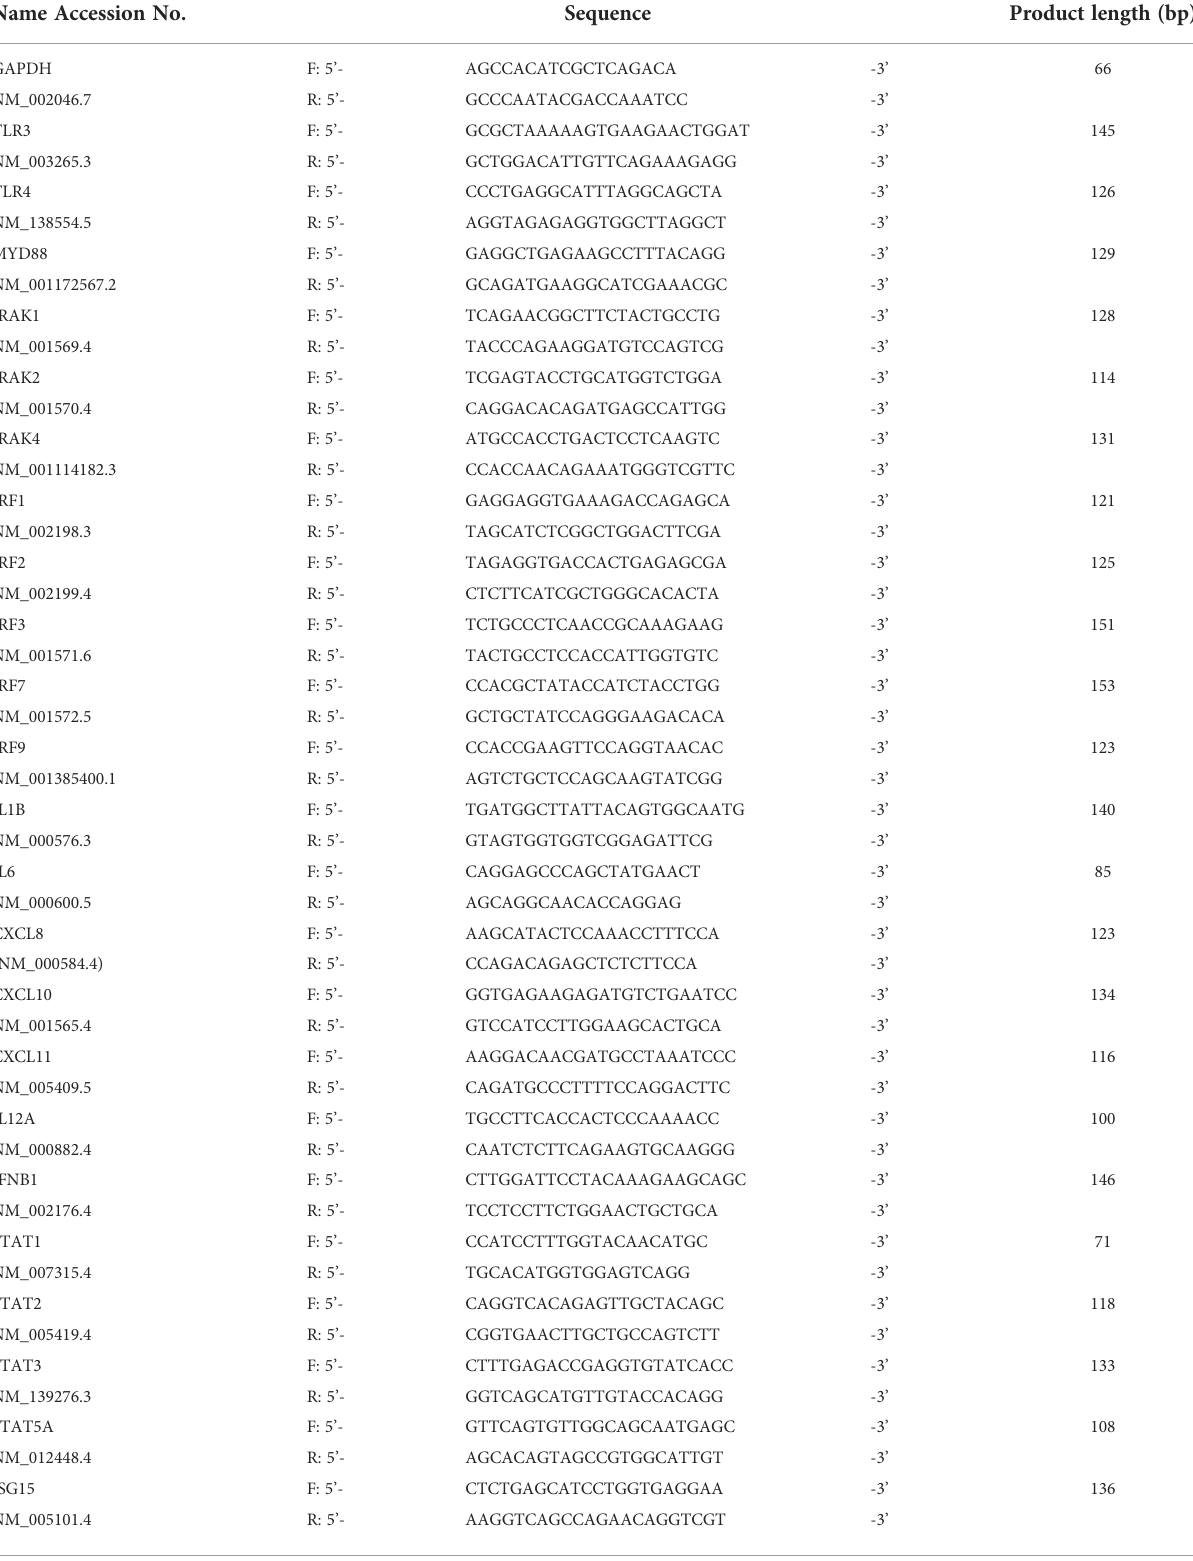
TABLE 1 Primers for real-time